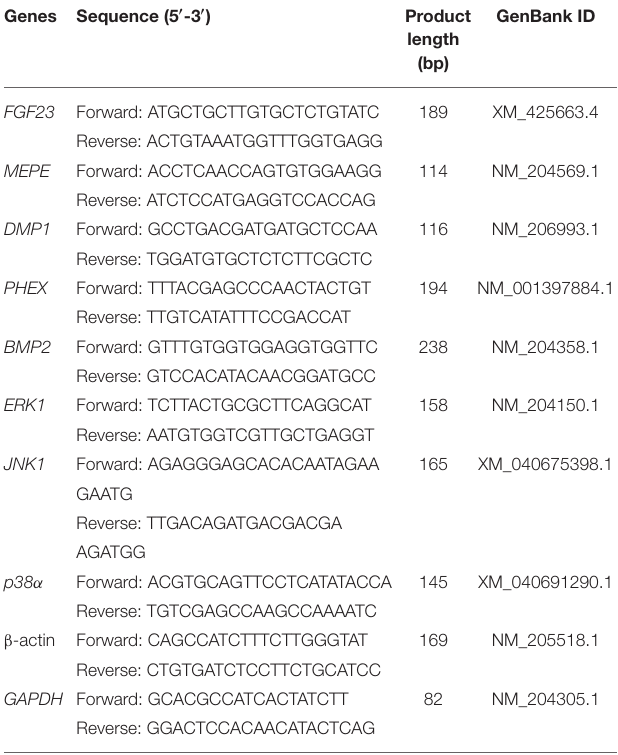
TABLE 1 | Primers used for the target and reference genes. Genes Sequence (5 ′ -3 ′ ) Product